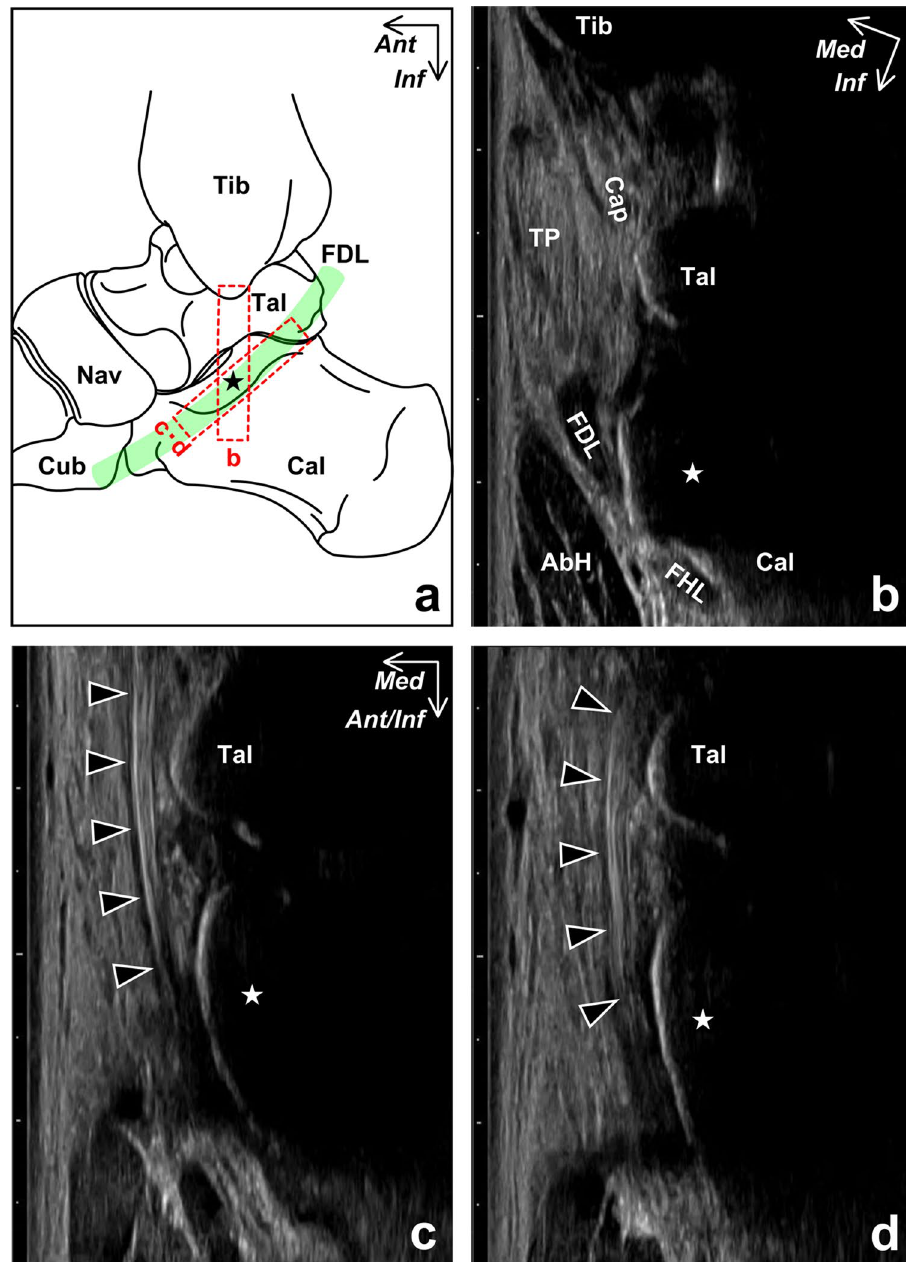
Figure 5. In vivo ultrasound images of the flexor digitorum longus in sitting (without the foot being placed on the ground) and standing. Schematic illustration ( a ), the medial aspect of the right ankle, indicates the ultrasound probe location (red dotted boxes) for visualizing the short ( b ) and long ( c , d ) axis images of the flexor digitorum longus (FDL). The FDL locates inferomedial to the sustentaculum tali (star) ( b ), and its curvature of the running course (arrowheads) slightly increased from sitting ( c ) to standing ( d ). AbH abductor hallucis, Cal calcaneus, Cap joint capsule, Cub cuboid, FHL flexor hallucis longus, Nav navicular, Tal talus, Tib tibia, TP tibialis posterior, Ant anterior, Ant/Inf anteroinferior, Inf inferior, Med